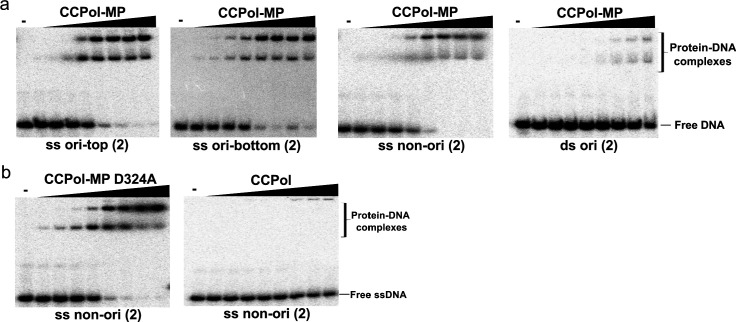
Binding of CCPol, CCPol-MP, and CCPol-MP D324A to 30-nt ss- and ds-DNA oligos representing a fragment of the putative origin of replication (ori) or an unrelated sequence (non-ori) – repeat of the experiments shown in (a) Figure 5a and (b) Figure 5b.